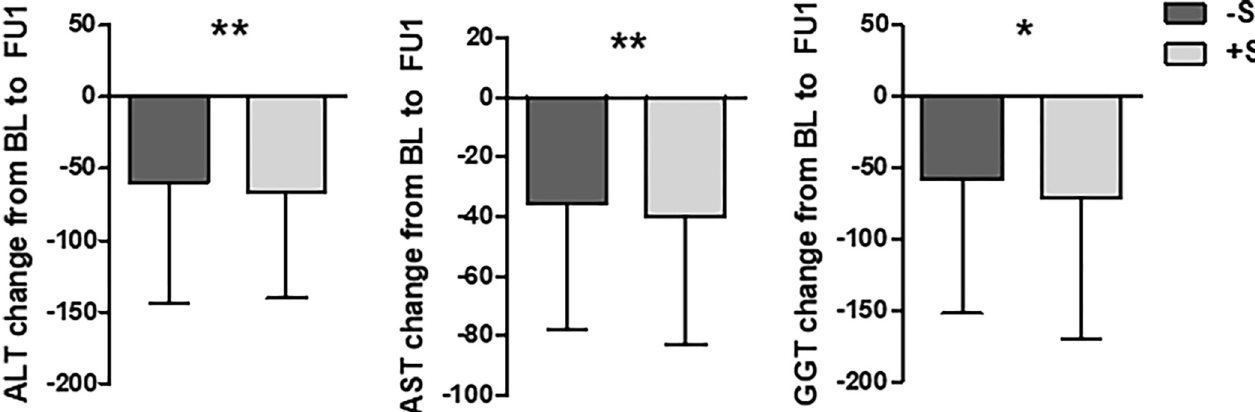
Fig 2. Change of serum liver enzymes from BL to FU1 for HCV patients with steatosis (+S) and without steatosis (-S) and without fibrosis progression. Mean ± SD. � = p < 0.05, �� = p < 0.01.